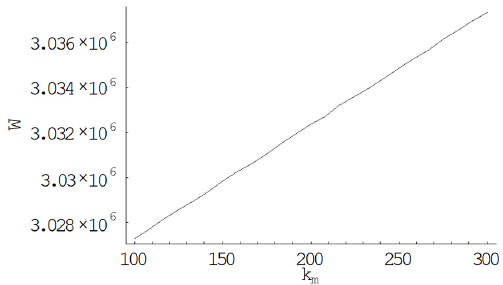
Figure 8. Total cost versus parameter k m.